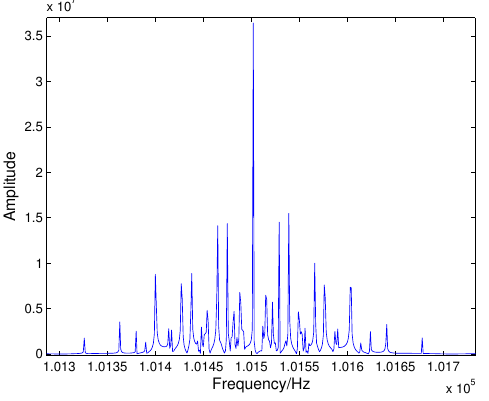
Figure 3. The spectra of the cross-correlation function (CCF) for a target containing 17 scatterers.